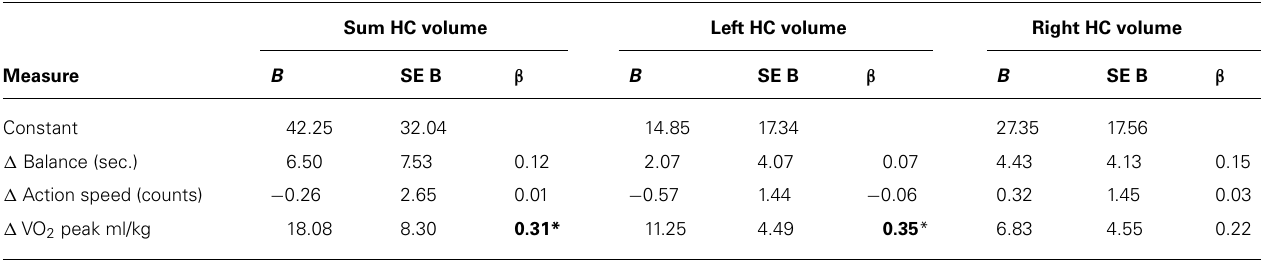
Table 7 | Regression statistics for hippocampal volume at t 3 (sum HC volume: sum of left and right volume, left HC volume, right HC volume) as dependent variable and changes in motor fitness domains that showed significant changes ( (cid:2) Balance,Action speed) and changes in cardiovascular fitness ( (cid:2) VO 2 peak) from t 1 to t 3 as independent